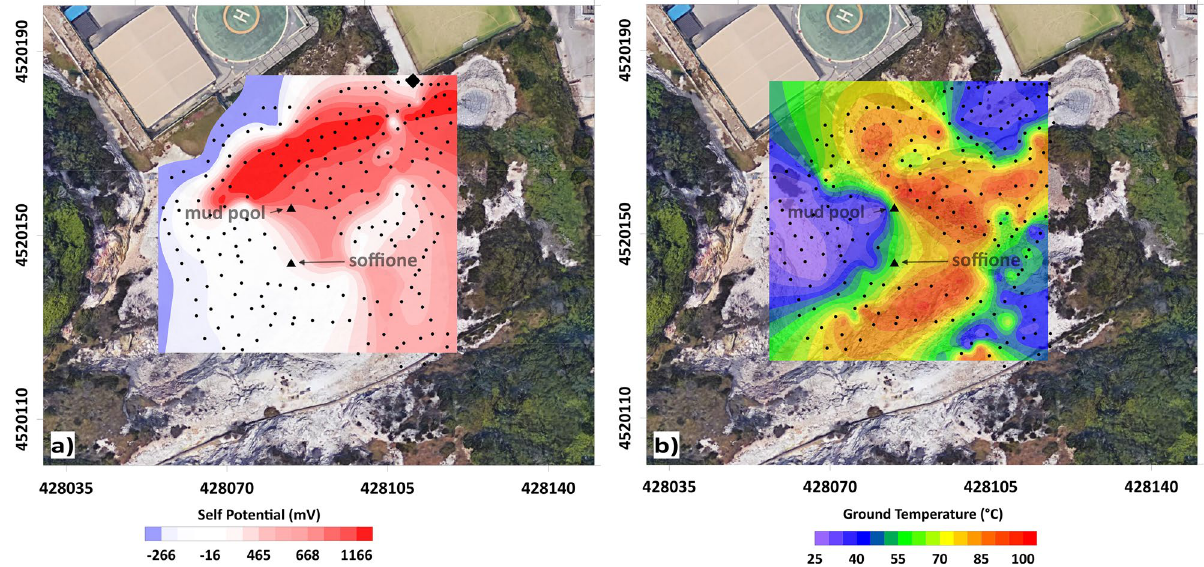
Figure 5. SP anomaly ( a ) and ground temperature ( b ) maps relative to the PFF. The color bars indicate the SP (in mV) and the ground temperature (°C) scales. In both maps, black dots indicate the measurement point positions. The black diamond in panel ( a ) indicates the zero-potential reference point. The figure was created using the MATLAB R2020b commercial software (https:// www. mathw orks. com/ produ cts/ MATLAB. html) and postprocessed using the Corel Draw 17 commercial software (https:// www. corel draw. com/ it/ produ ct/ corel